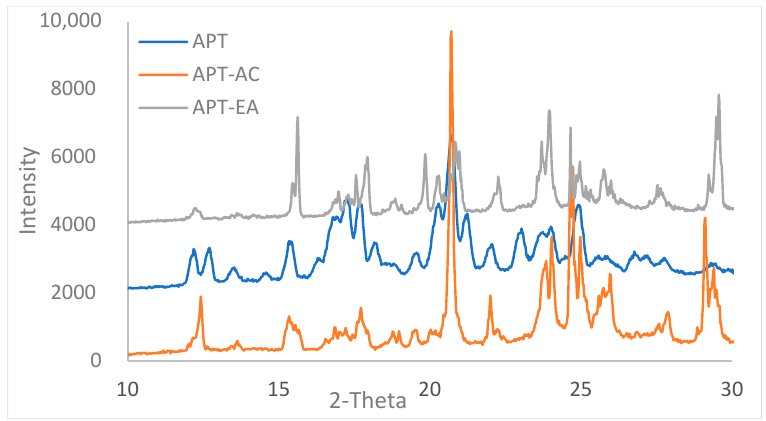
Figure 4. Powder XRD.